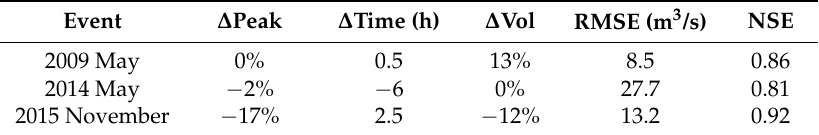
Table 2. V flo TM calibration summary.